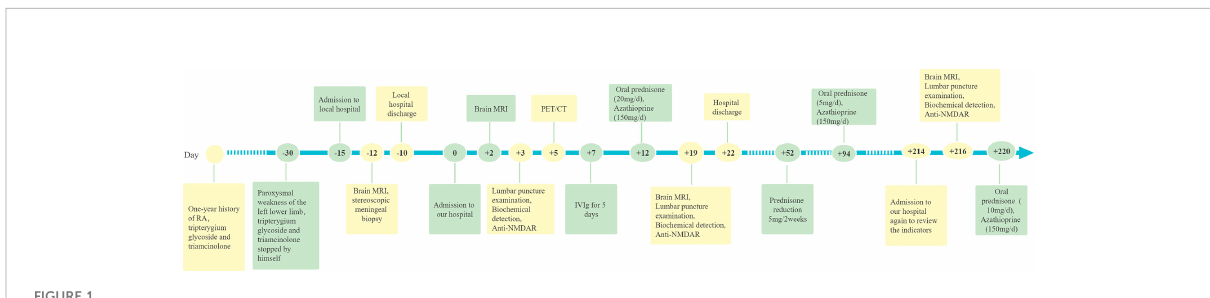
FIGURE 1 Timeline of the clinical manifestations and treatment